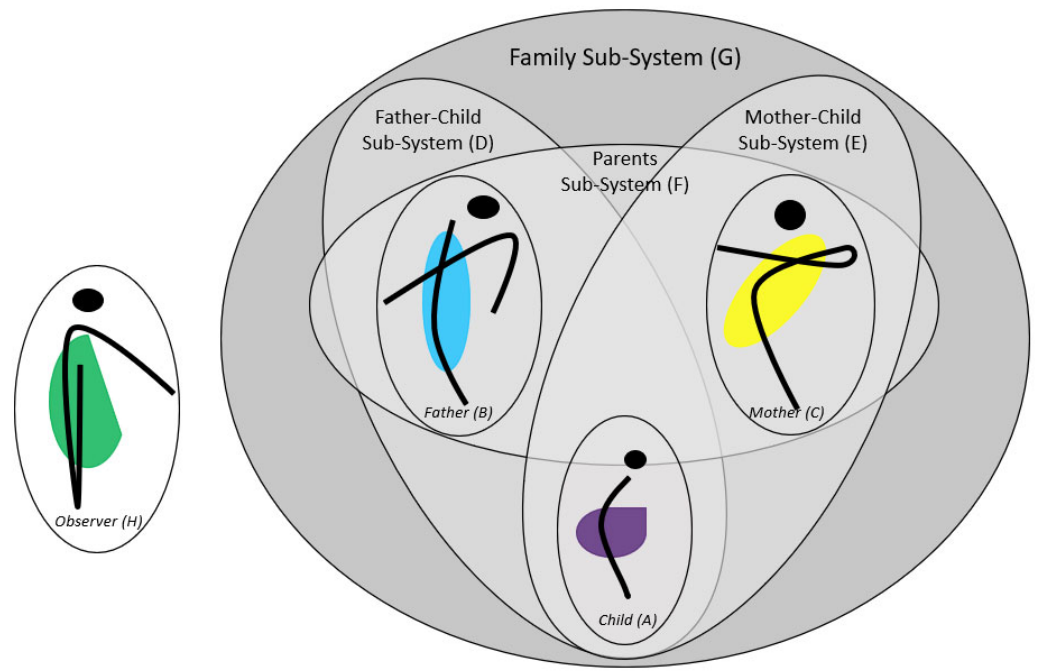
Figure 1. Family Systems Perspective on Attachment and Psychopathology.